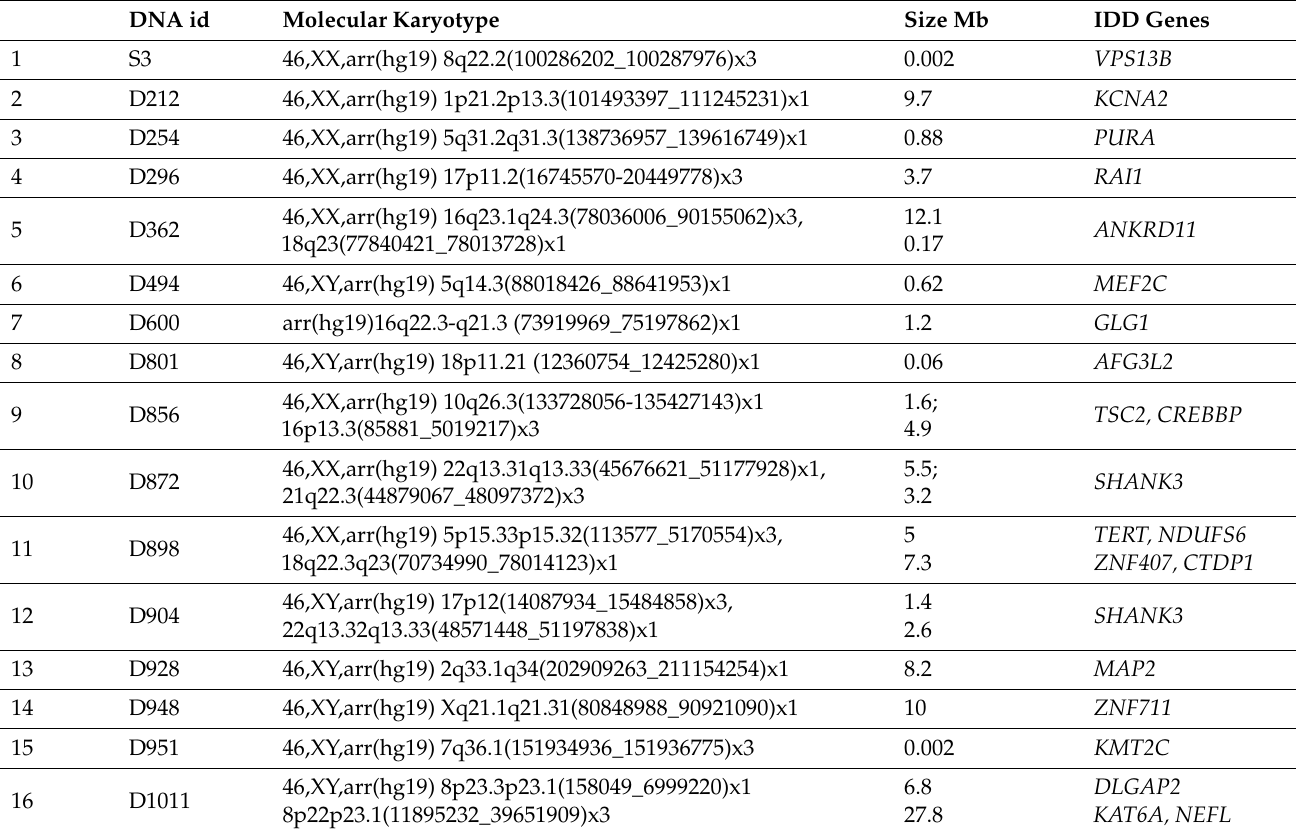
Table 4. Pathogenic and likely-pathogenic